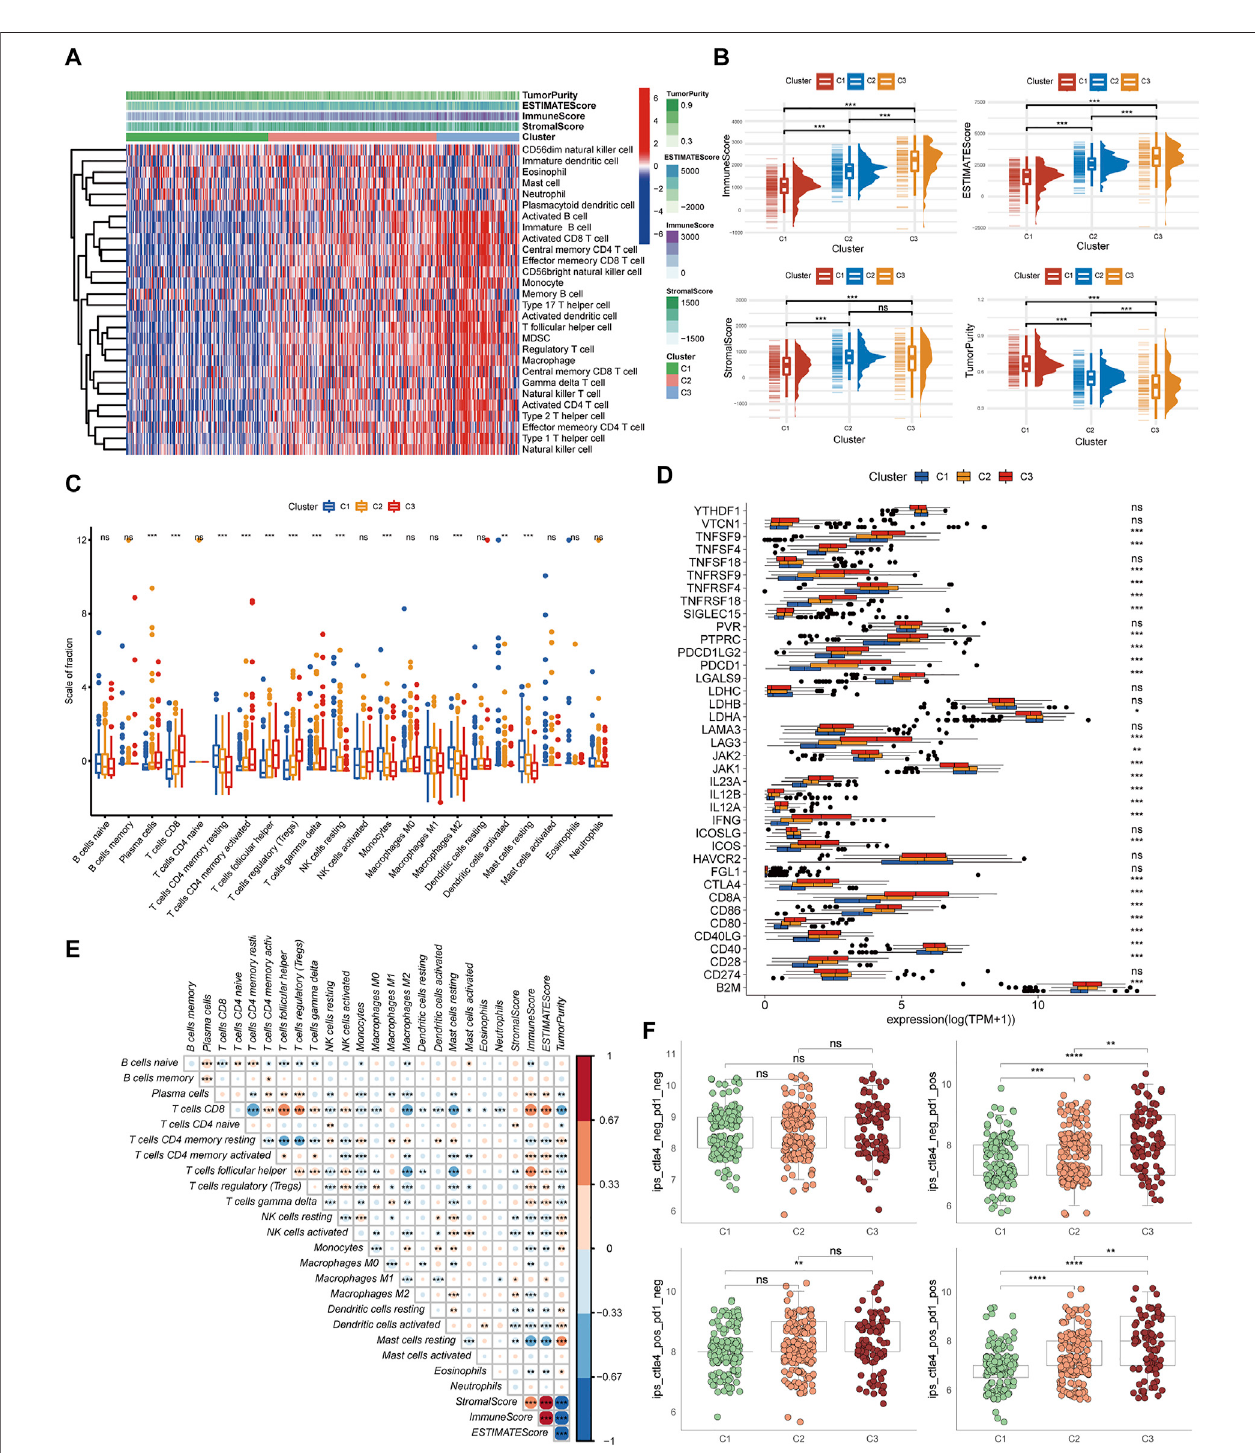
FIGURE2| Immune landscapeand drugresponseofpyroptosis subtypes. (A) Theheatmap ofimmunecell in fi ltration annotationsand immunemicroenvironment scoresinpyroptosissubtypes. (B) Thelevelsofestimatescore,immunescore,stromalscore,andtumor purityinpyroptosissubtypes. (C) Therelativeabundanceof22 immune cell types in pyroptosis subtypes. (D) The expression levels of common immune checkpoints among pyroptosis subtypes. (E) The heatmap of the interaction between immune cells. (F) IPS comparison among the three pyroptosis subtypes of the patients with ccRCC in the CTLA4 negative/positive or PD-1 negative/ positive groups. CTLA4_positive or PD-1_positive, respectively, stood for anti-CTLA4 or anti-PD-1 therapy (*** p < 0.001, ** p < 0.01, * p < 0.05).